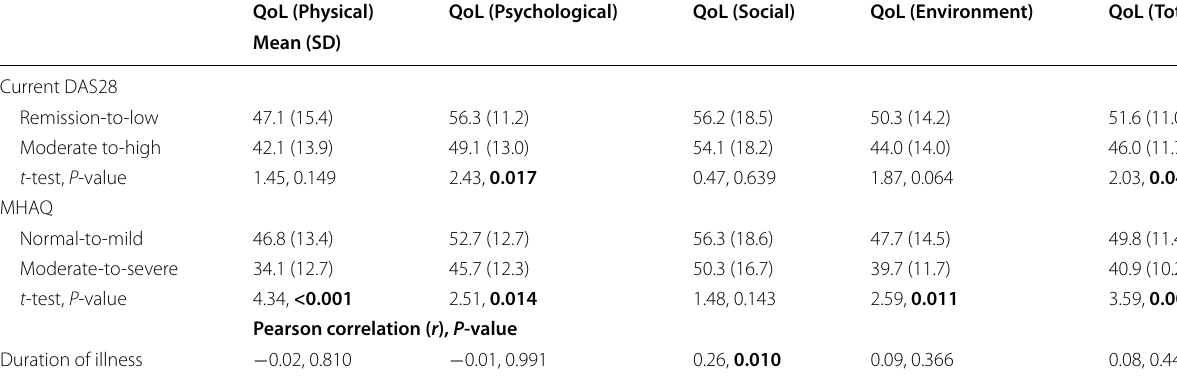
Significant values at P < 0.05 are presented as bold QoL quality of life, DAS28 Disease Activity Score 28, MHAQ Modified Health Assessment